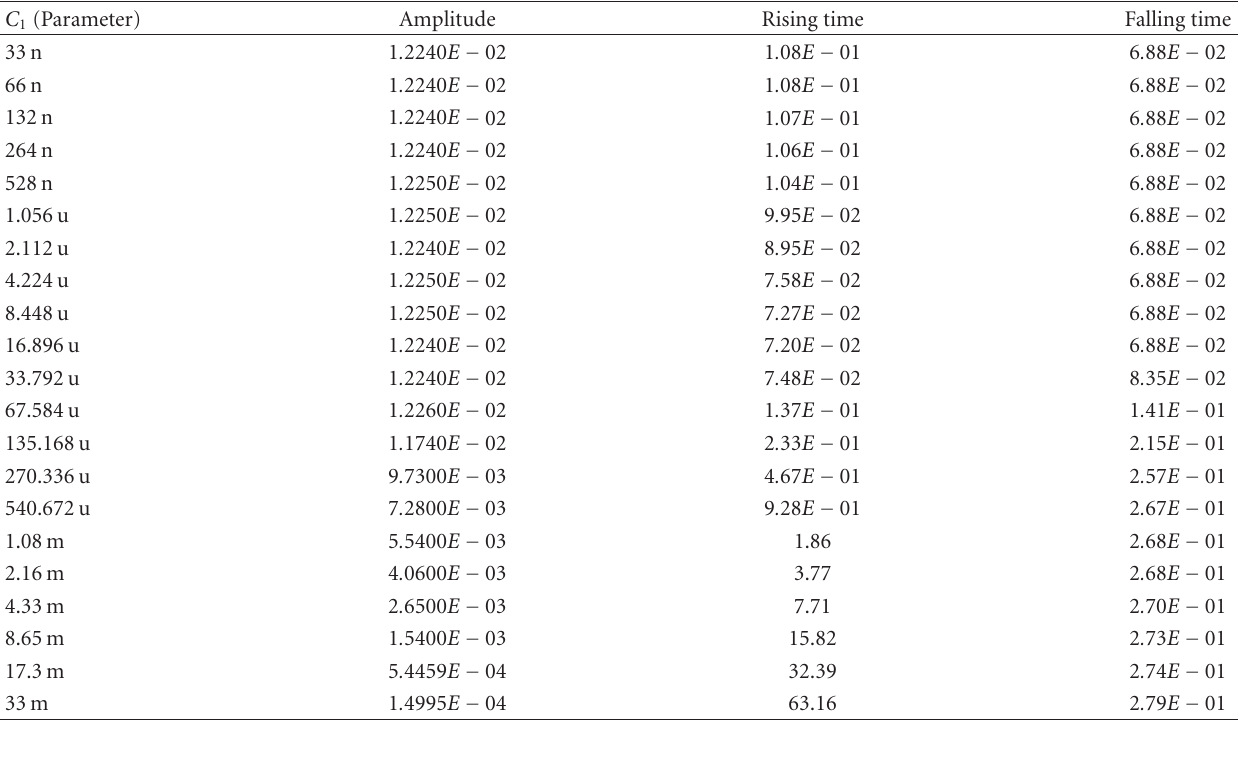
Table 2: Output data of the pulse parameter according to a change of the capacitance of C 1 .